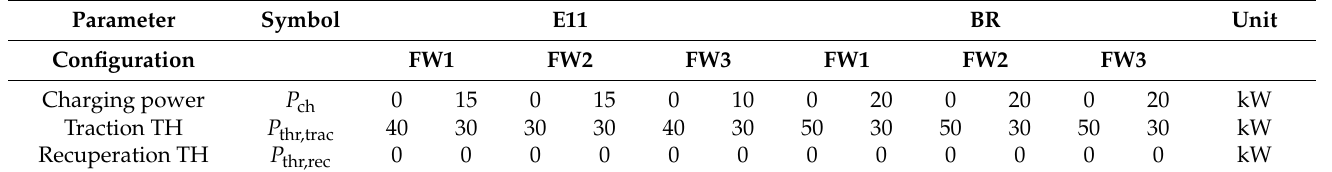
Table 5. Optimal threshold values of charge controller for the KESS configurations.